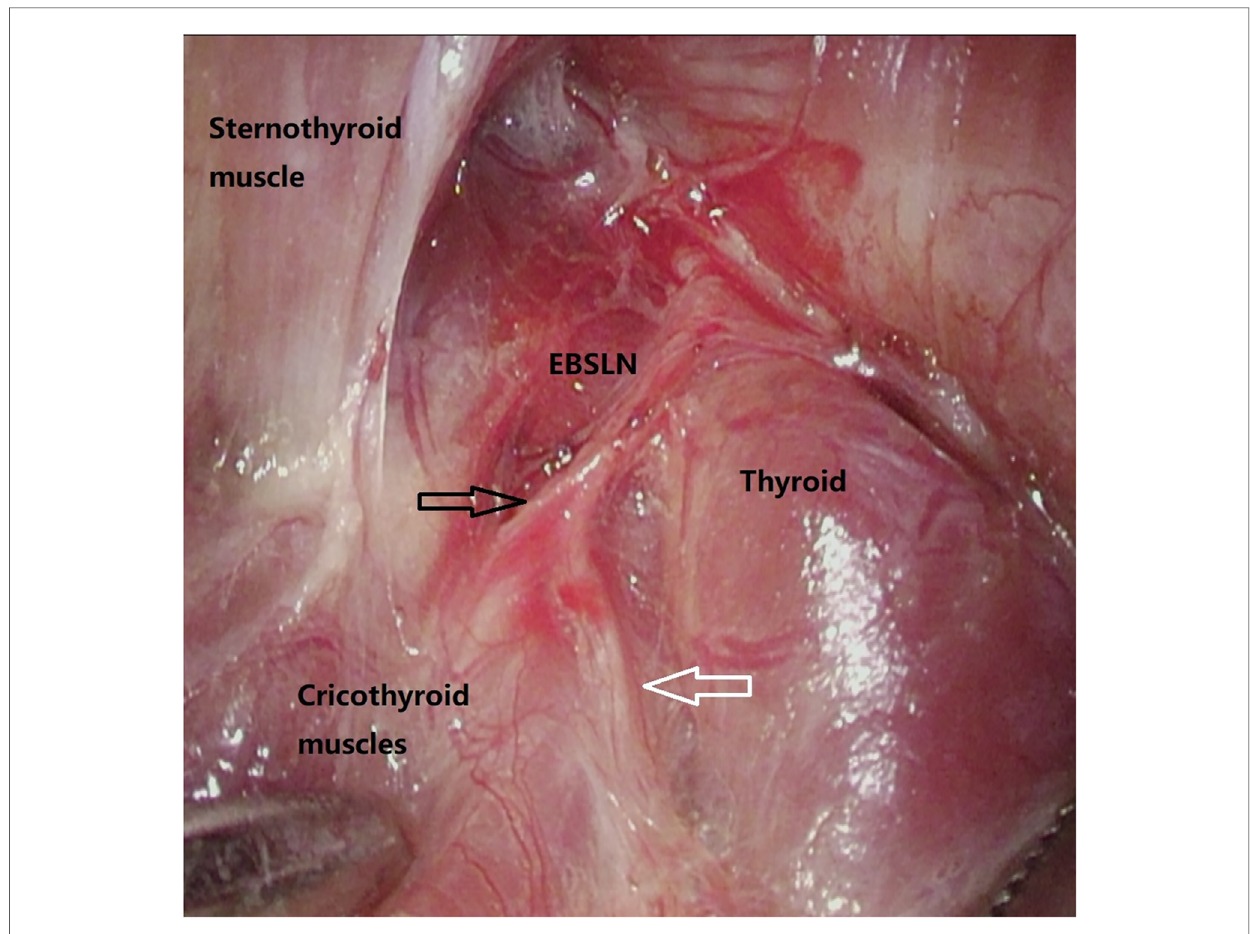
FIGURE 1 Visually expose of EBSLN by video-assisted view angle. Black arrow: EBSLN toward cricothyroid muscles, white arrow: communicating branch between EBSLN and